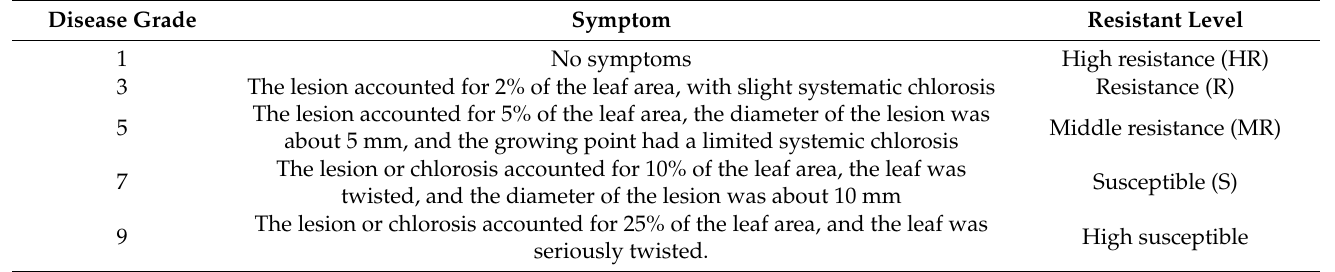
Table 2. Criteria used to classify the halo blight disease severity and resistance of Jilv 20 plants.